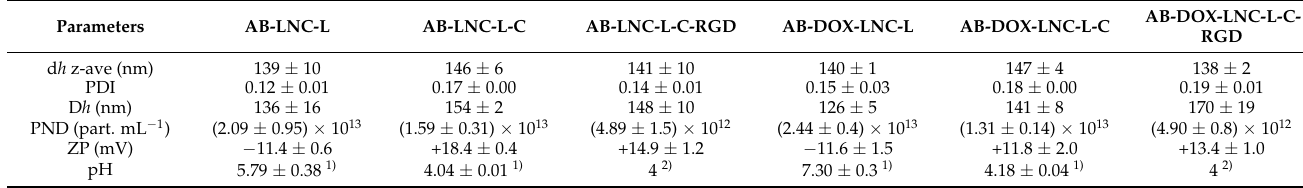
Table 1. Physicochemical properties of the